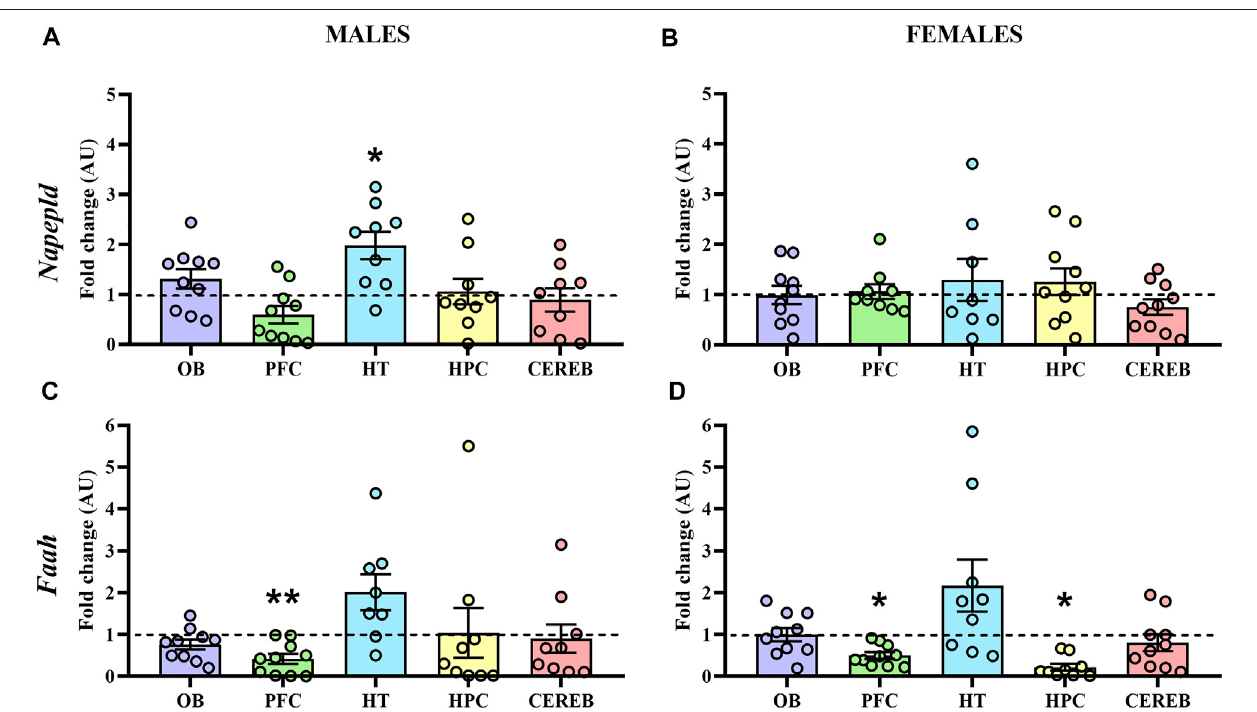
FIGURE 7 | Gene expression of the AEA metabolizing enzymes in WT (male n = 10; female n = 10) and APP/PS1 (male n = 10; female n = 10) mice at 3 months of age. RT-qPCR assay was performed to analyze the expression of Napepld and Faah in (A,C) males and (B,D) females, respectively. The X axis shows the fi ve brain- regions analyzed: olfactory bulb (OB), prefrontal cortex (PFC), hypothalamus (HT), hippocampus (HPC), and cerebellum (CEREB). The Y axis shows the mRNA expression as a fold change comparing male and female APP/PS1 mice with its corresponding WT (represented as a dashed line). Values are presented as the mean ± SEM. * p < 0.05, ** p < 0.01, vs. WT group (genotype effect); (Mann – Whitney